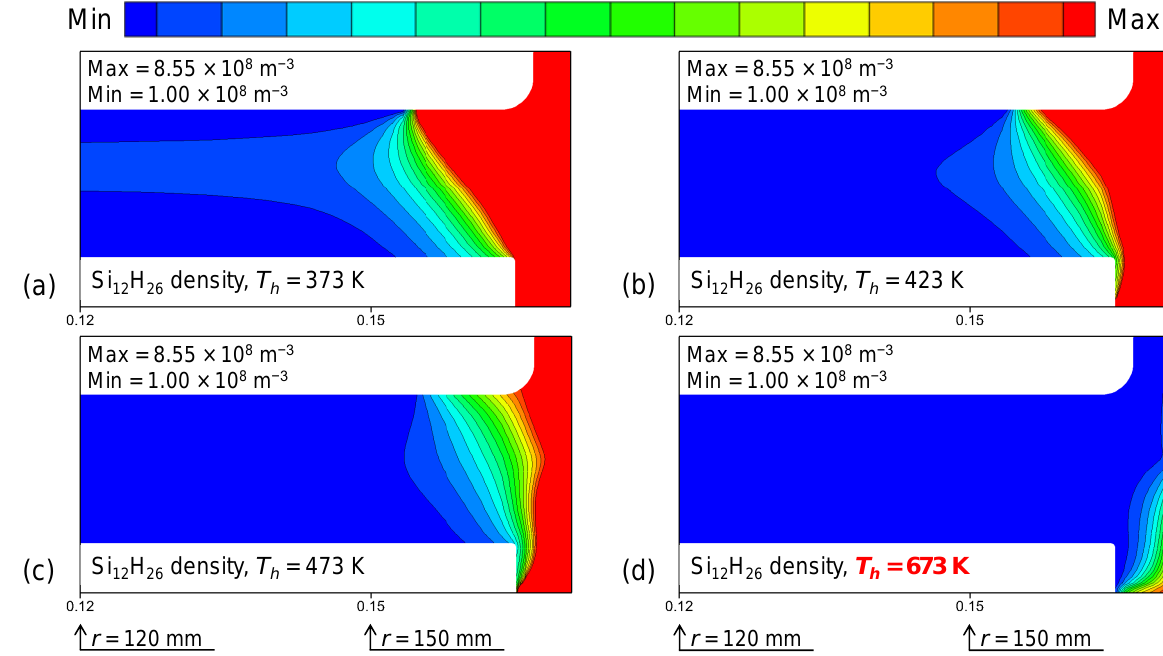
Figure 12. Effects of the showerhead temperature ( T sh ) on the spatial distribution of high-order silanes. Spatial variations in the Si 12 H 26 density distributions (m − 3 ) for ( a ) Case 2 ( T sh = 373 K), ( b ) Case 3 ( T sh = 423 K), ( c ) Case 4 ( T sh = 473 K), and ( d ) Case 5 ( T sh = 673 K).